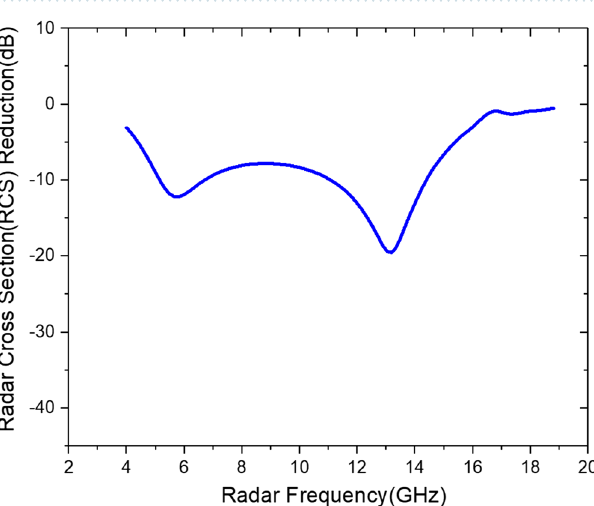
Figure 3. Electric and magnetic field distributions of a double square loop pattern at 12.7 GHz.